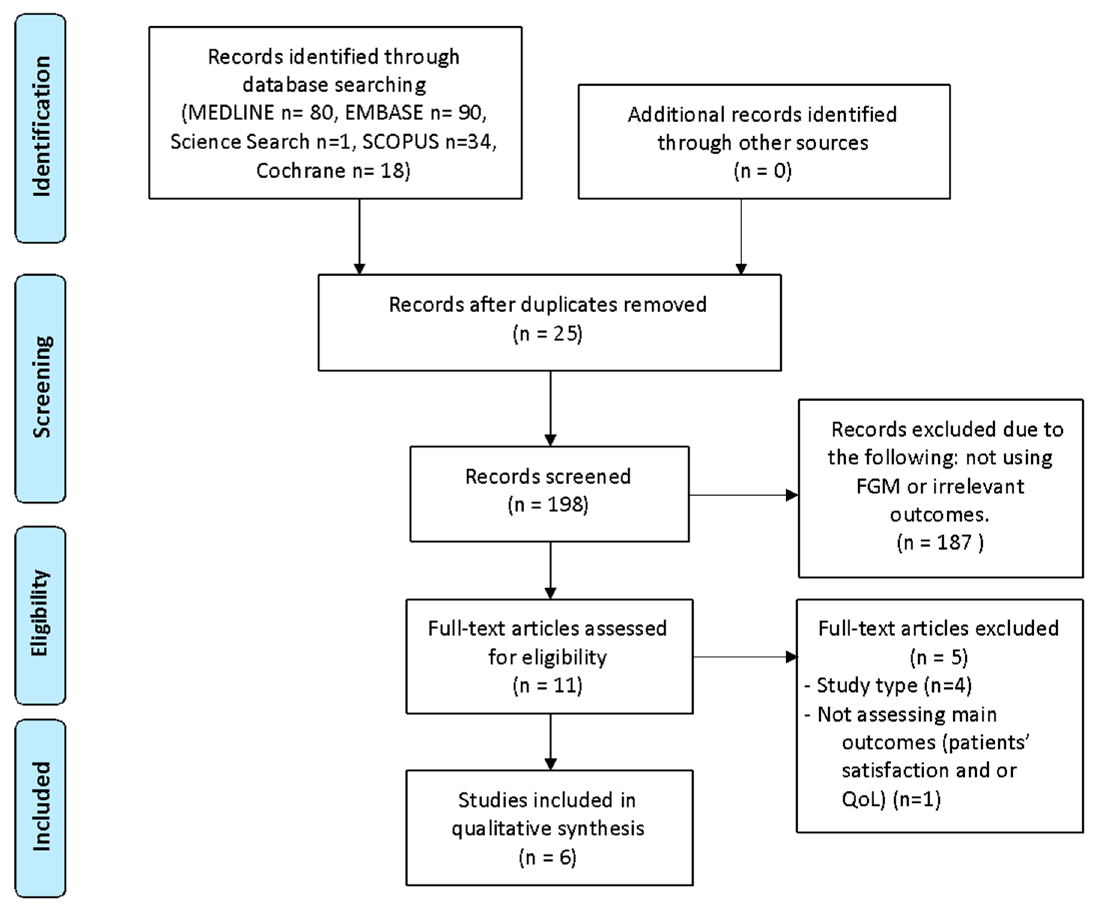
Figure 1. Literature search Preferred Reporting Items for Systematic Reviews and Meta-Analyses (PRISMA) consort diagram.